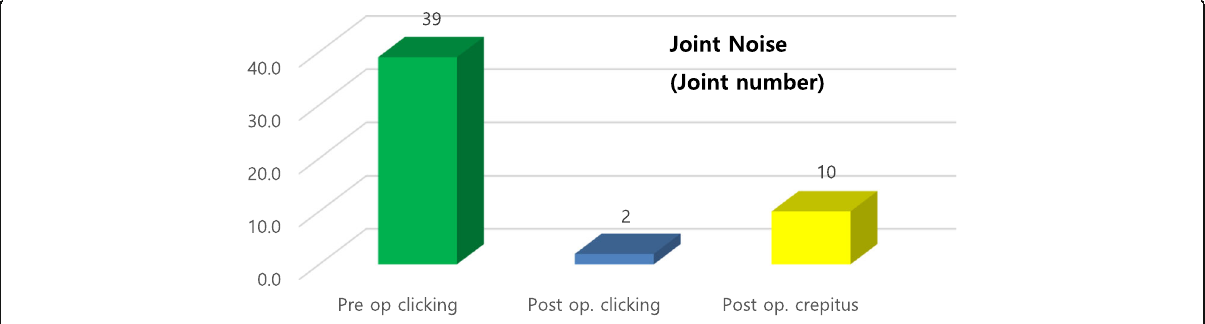
Fig. 12 Evaluation of preoperative (Pre op.) and postoperative (Post op.) TMJ noise